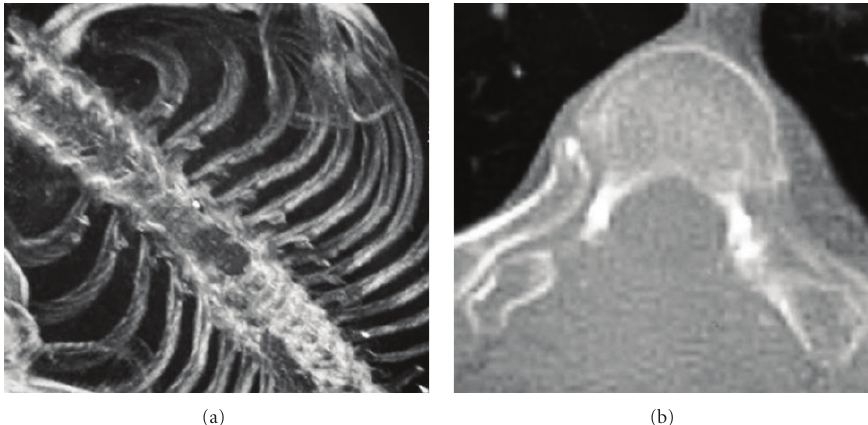
Figure 2: Postoperative (1 year) CT scan of the lesion at Th3-Th4 level, demonstrating laminectomy and absence of local